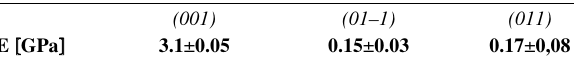
Table 1: The results of Young’s modulus (E) obtained from the most prominent faces of simvastatin crystals given as the average value of all measured